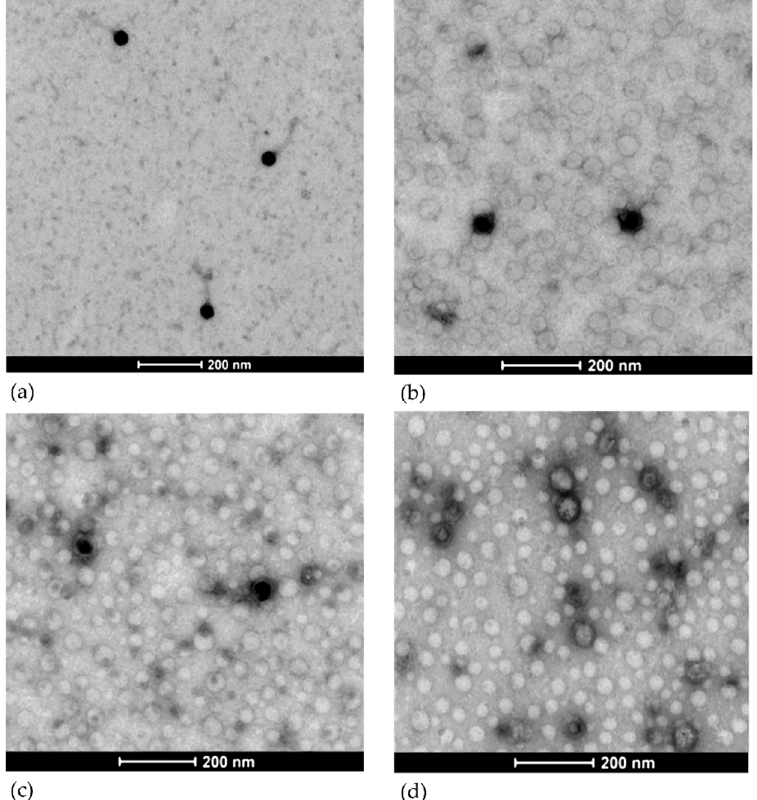
Figure 4. Negative staining transmission electron microscopic images of ( a ) vB_EcoS_K1-ULINTec2, Siphoviridae . ( b ) vB_EcoP_K1-ULINTec4, Podoviridae . ( c ) vB_EcoP_K1-ULINTec6, Podoviridae . ( d ) vB_EcoP_K1-ULINTec7, Podoviridae .